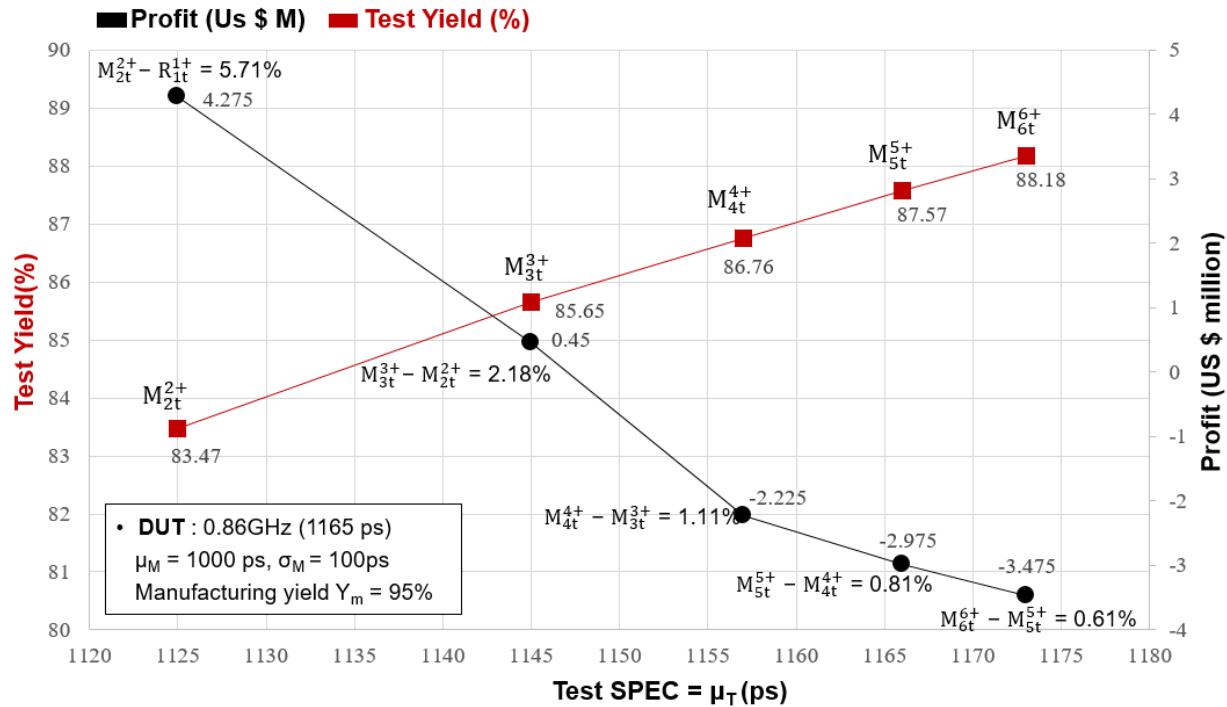
Figure 13. Enhanced test method to increase test yield and company profit.